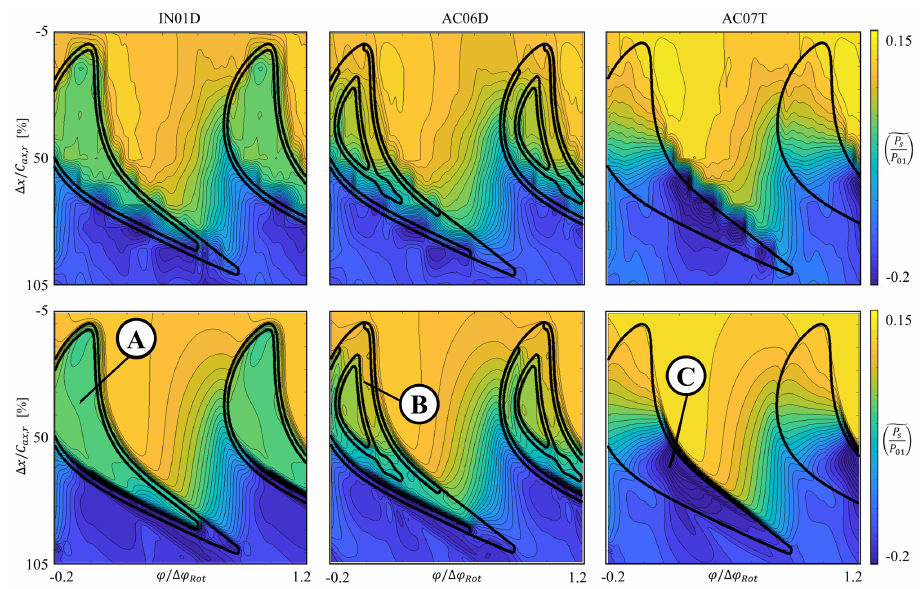
Figure 4. Contours of experimental ( top ) and numerical ( bottom ) normalized P s / P 01 in the rotor-relative